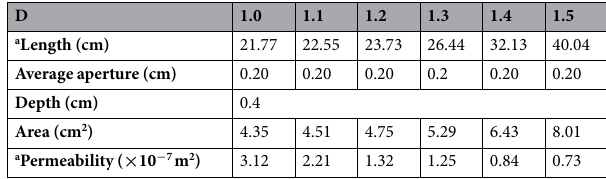
Table 1. Characteristics of the rough fracture models. a Ju et al . 36 .